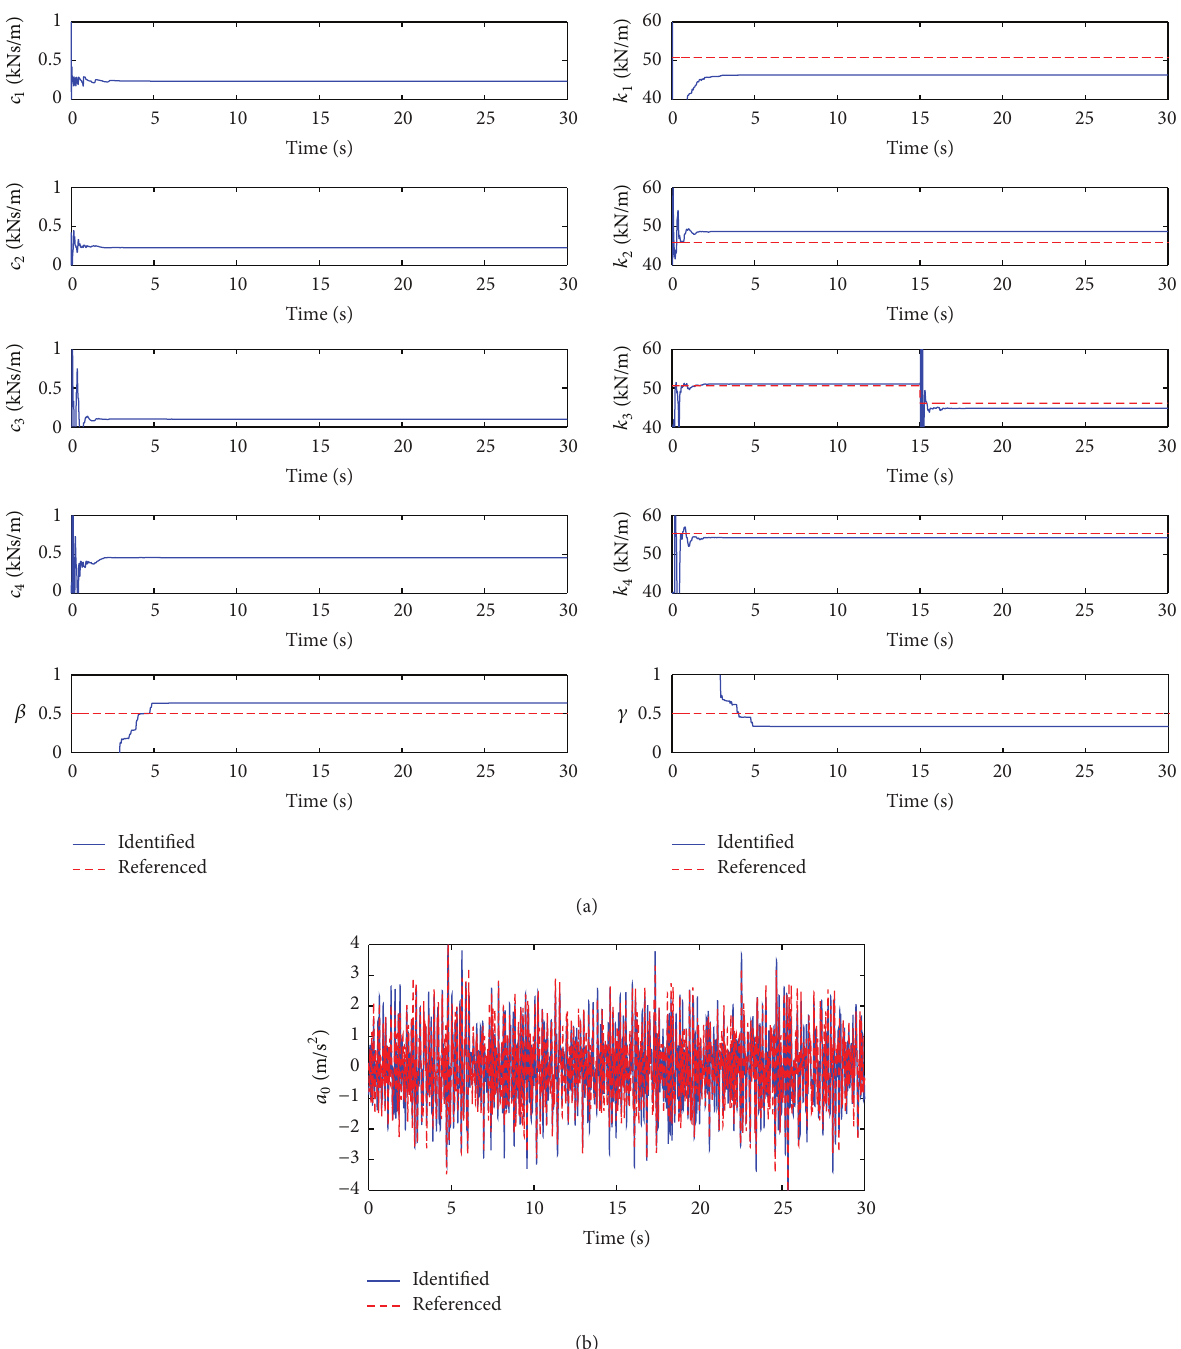
Figure 8: Identified results for Case 2: (a) identified parameters; (b) identified